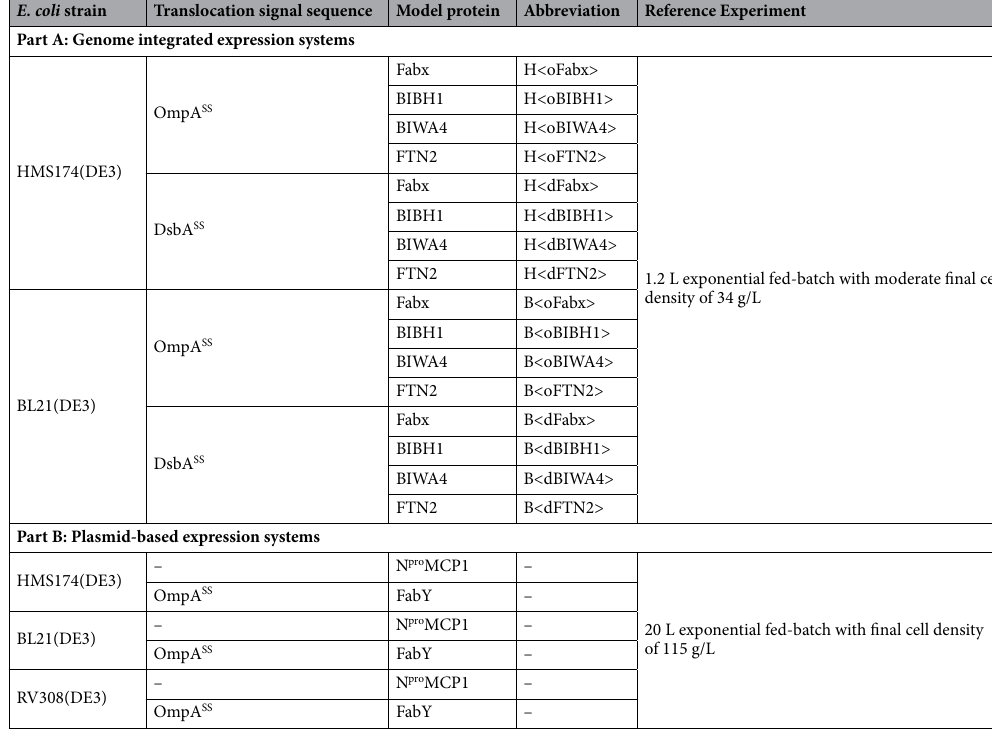
Table 1. List of all expression clones and abbreviations. <> indicates genomic integration and () indicates plasmid-based systems.